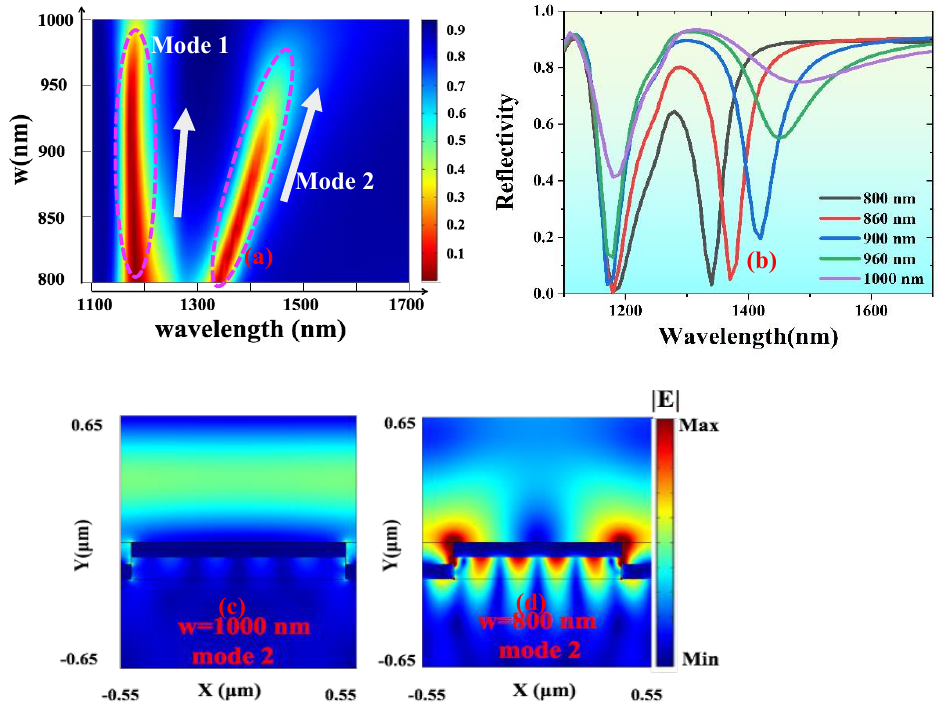
Figure 6. ( a ) When h1 = 120 nm, h2 = 80 nm, and p = 1100 nm, the reflectance of the device is in the variation range of 600 nm–800 nm for the grating width w. ( b ) Comparison of reflection spectra of devices at different grating widths. ( c , d ) Electric field distribution of Mode 2 when w is 800 nm and 1000 nm, respectively.